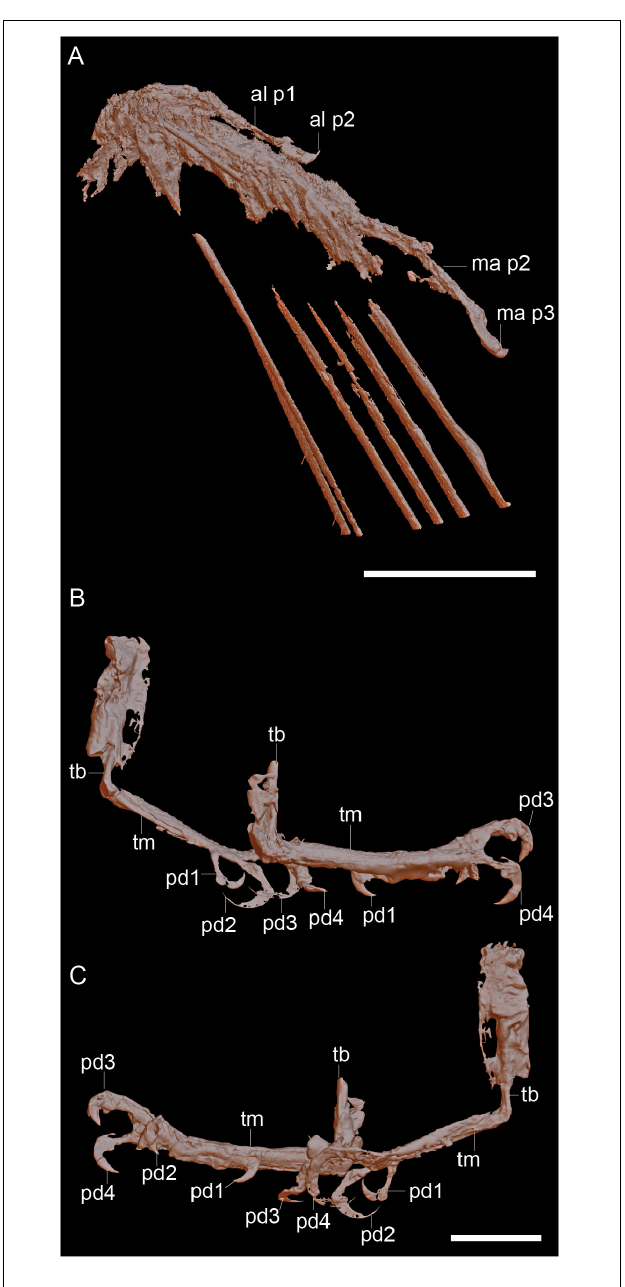
FIGURE 2 | Raw CT data of the right hand (A) and the feet viewed from the right (B) and viewed from the left (C) . Scale bars equal 5 mm. Anatomical abbreviations: al p1, alular digit phalanx 1; al p2, alular digit phalanx 2; ma p2, major digit phalanx 2; ma p3, major digit phalanx 2; pd1-4, pedal digits 1-4; tb, tibiotarsus; tm, tarsometatarsus.